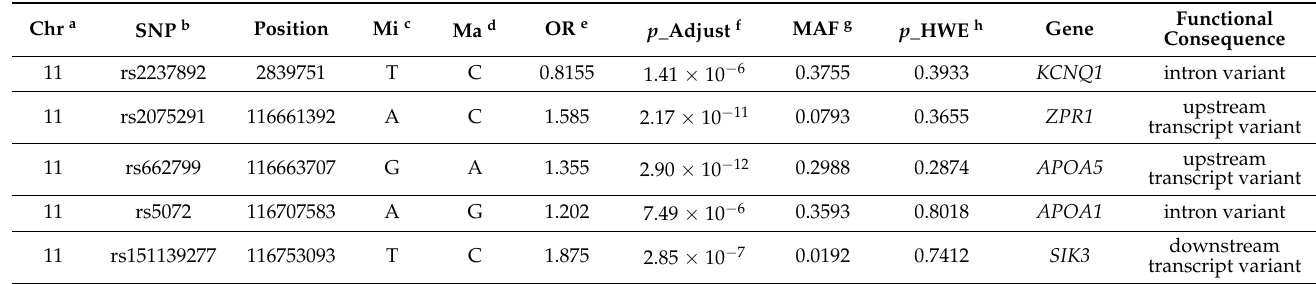
Table 2. Characteristics of genetic variants to influence 3GO risk selected by genome-wide association study (GWAS) in a Korean city hospital-based cohort.